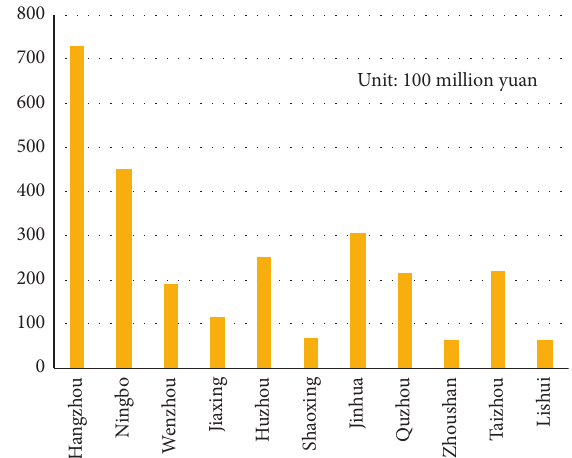
Figure 5: Comparison of structural shift component of tertiary industry.